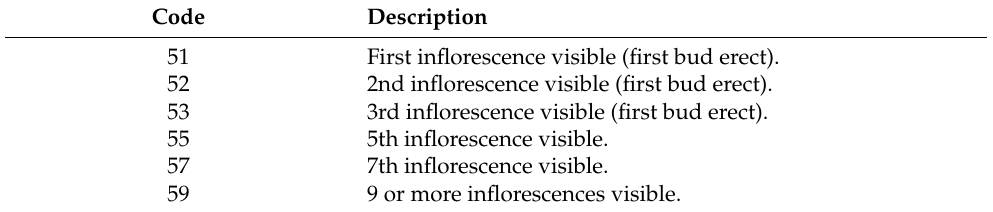
Table 4. Description of principal stage 5 (inflorescence emergence) of slender nightshade, based on the BBCH scale.